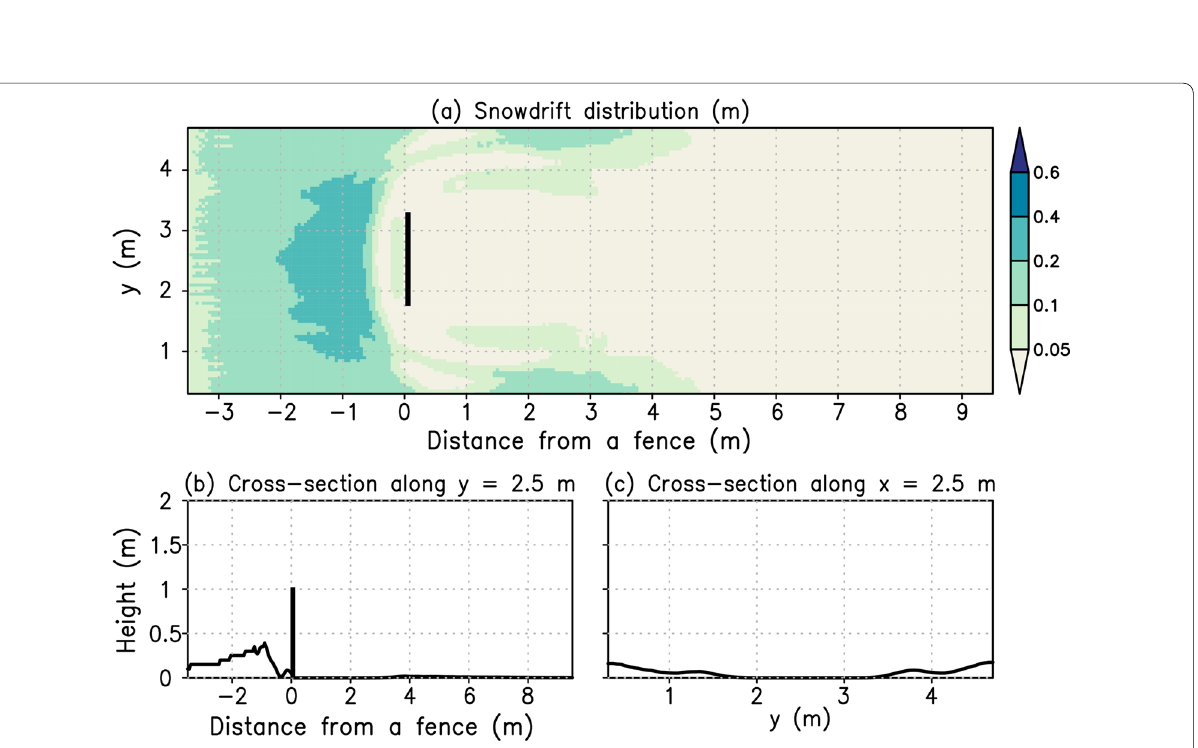
2.5 m and c x 2.5 m. The snowdrift is the sum of = =